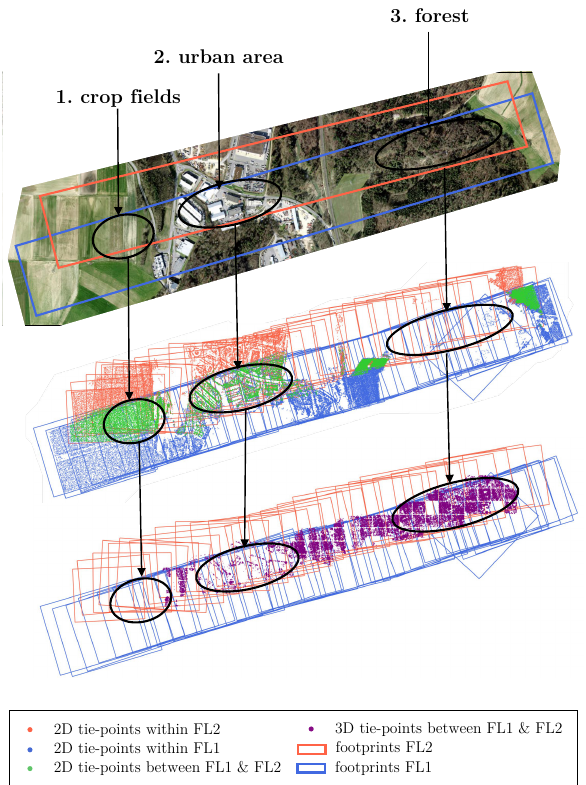
Figure 4. Distribution of 2D and 3D tie-points along the two flight lines and the mapping surface they correspond